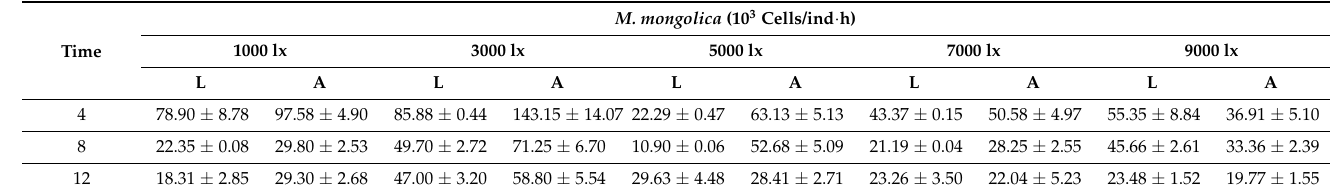
Table 3. Feeding rates of M. mongolica at two age stages under different light intensities (data are listed as the style of mean ± standard deviation, L and A represent larva and adult M. mongolica , respectively).